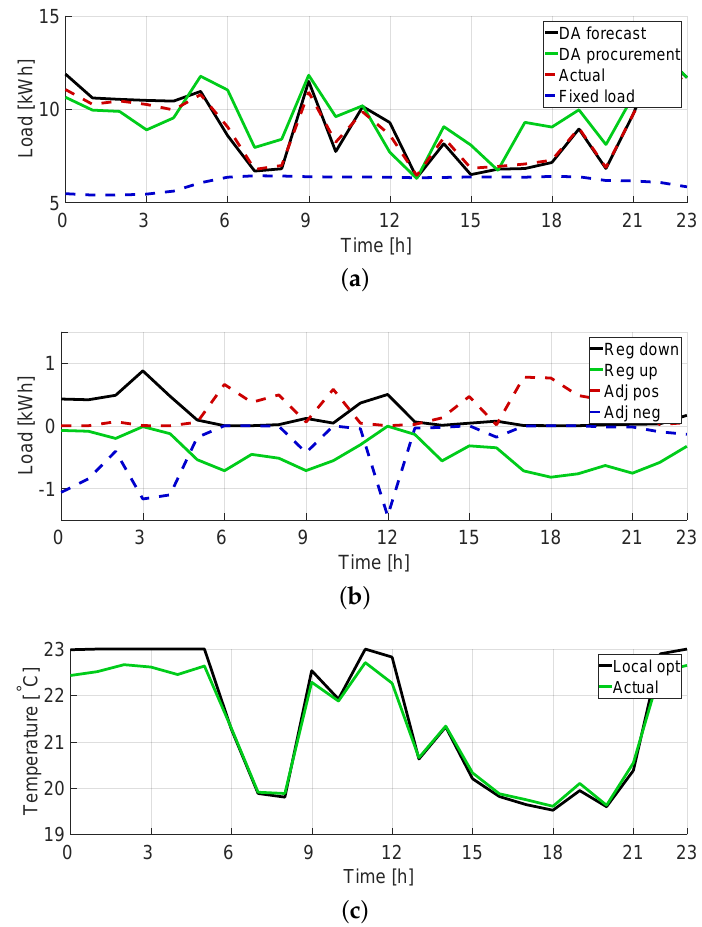
Figure 3. Average time series illustrating the operation. ( a ) DA forecast, DA procurement, actual simulated consumption, and fixed load; ( b ) Activated regulation and adjustments; ( c ) Locally optimized indoor temperature and the temperature after